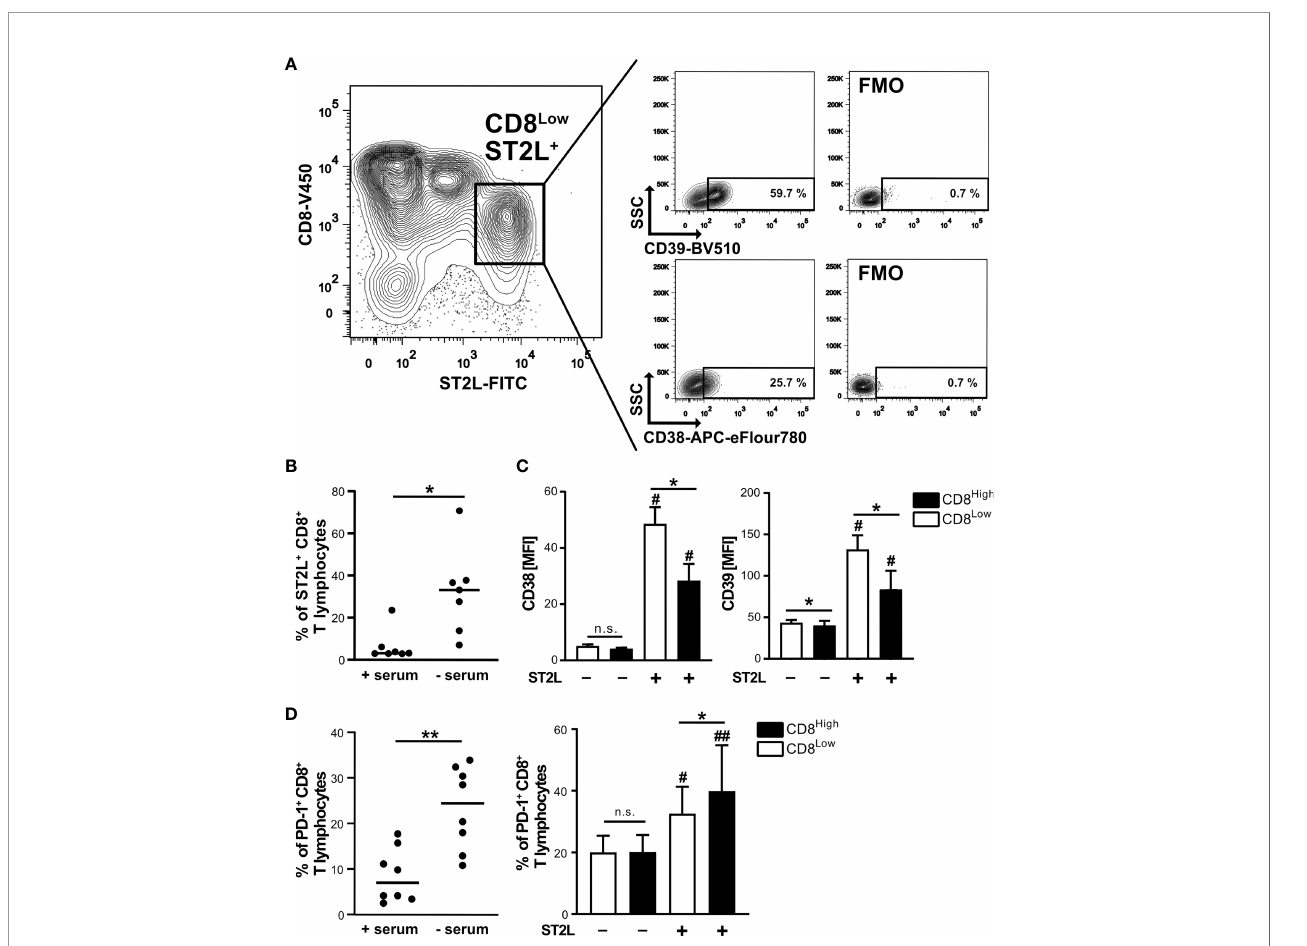
FIGURE 2 | High ST2L expression correlates with enhanced CD38, CD39 and PD-1 surface expression on CD8 + T lymphocyte subsets during nutrient deprivation. (A) CD38 and CD39 expression on CD8 Low ST2L + T lymphocytes during nutrient deprivation. CD8 + T lymphocytes were puri fi ed from human PBMC and cultivated for 40 h under serum withdrawal. Representative FACS plots show the percentages of CD39 + (upper plots) or CD38 + (lower plots) CD8 Low ST2L + T lymphocytes. FMO: Fluorescence minus one stainings (without either CD39-BV510 or CD38-APC-eFlour780). (B) ST2L expression on all gated CD8 + T lymphocytes during serum starvation (- serum) compared to a cultivation control (+ serum). The horizontal line indicates the median calculated from n = 8 individual donors from three independently performed experiments. (C) Mean fl uorescence intensities (MFI) of CD38 (left) and CD39 (right) after gating of CD8 High (black bars), CD8 Low (white bars) and ST2L-positive (+) or ST2L-negative ( – ) T lymphocytes. Data are means ± SD from n = 6 different donors from three independently performed experiments. (D) Percentages of PD-1 + CD8 + T lymphocytes after 40 h cultivation with either no serum or 10% autologous donor serum (left graph) and on prede fi ned CD8 + T lymphocyte subpopulations during starvation (CD8 Low white bars, CD8 High black bars). The horizontal line indicates the mean, bars represent means ± SD. Flow cytometry data was obtained from n = 8 different donors from three independently performed experiments. (C, D) # p ≤ 0.05, ## p < 0.01 for multiple comparisons of ST2L + and ST2L - subpopulations using Friedman test with Dunn´s post-test, *p ≤ 0.05, **p < 0.01, comparisons between groups using Wilcoxon matched-pairs signed rank